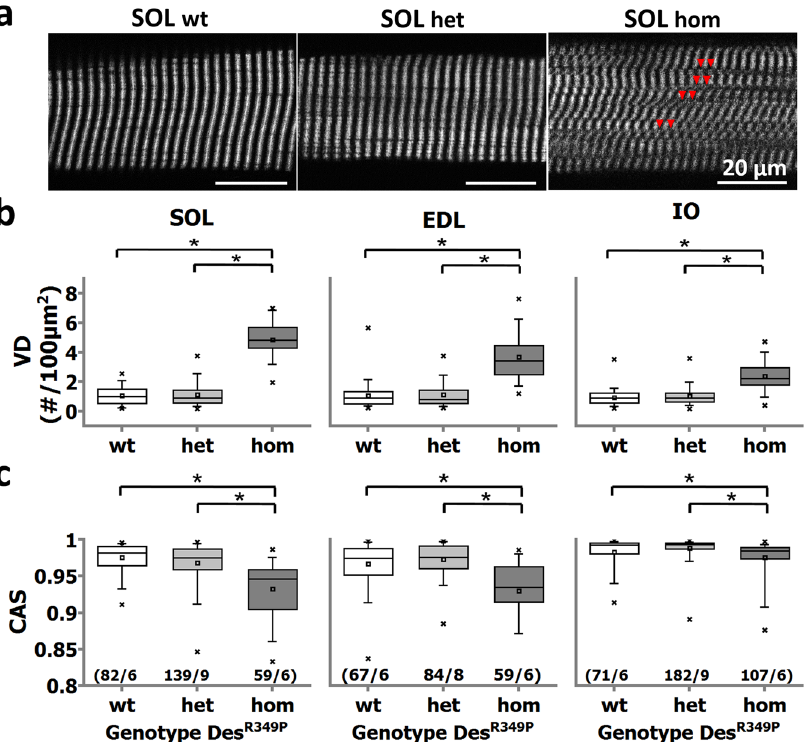
Figure 2. Morphometric analyses of cytoarchitecture in single muscle fibers from young Des R349P mice using SHG microscopy. ( a ) Representative SHG images from the middle section of a single fiber from a wt (Des wt/ wt ), het (Des R349P/wt ) and hom (Des R349P/R349P ) knock-in mouse. Hom muscle fibers show prominent disruptions of the myofibrillar lattice. This is analyzed in detail in ( b ) for the number of verniers ( VD ), and in ( c ) for the cosine angle sums (CAS). VD and CAS were significantly increased and decreased, respectively, in single fibers from different muscles examined (SOL, EDL, IO) in hom mice. Het mice showed values similar to the wt. (n/m) denotes n fibers from m animals. * p < 0.05, one-way ANOVA with post-hoc Bonferroni-correction. Scale bar: 20 µ